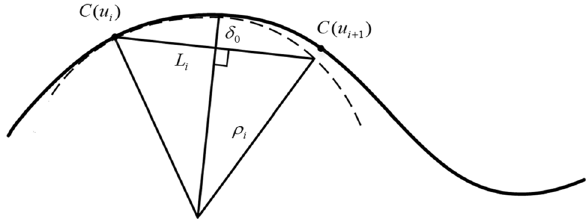
Figure 2. Schematic diagram of chord error.